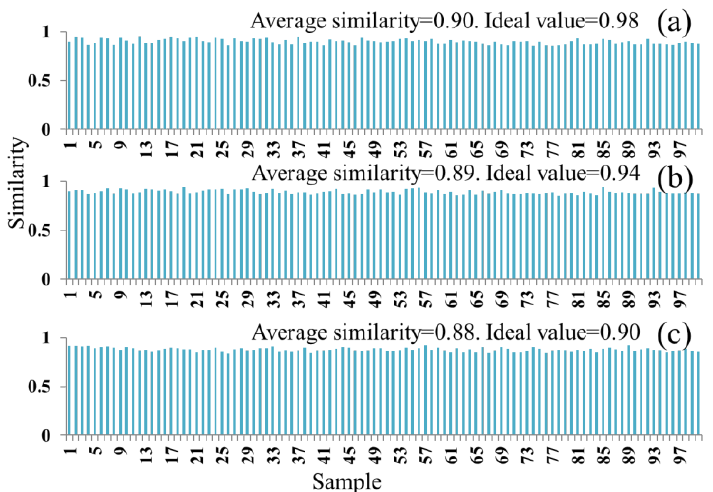
Figure 8. The registration similarity of the translation images. ( a ) [x = − 10, y = − 10]; ( b ) [x = − 30, y = − 30]; and ( c ) [x = − 50, y = − 50].